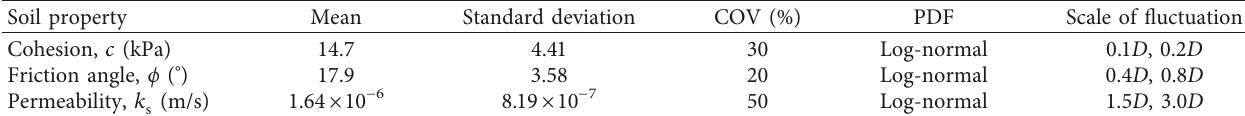
Table 2: Statistical properties of shear strength parameters.